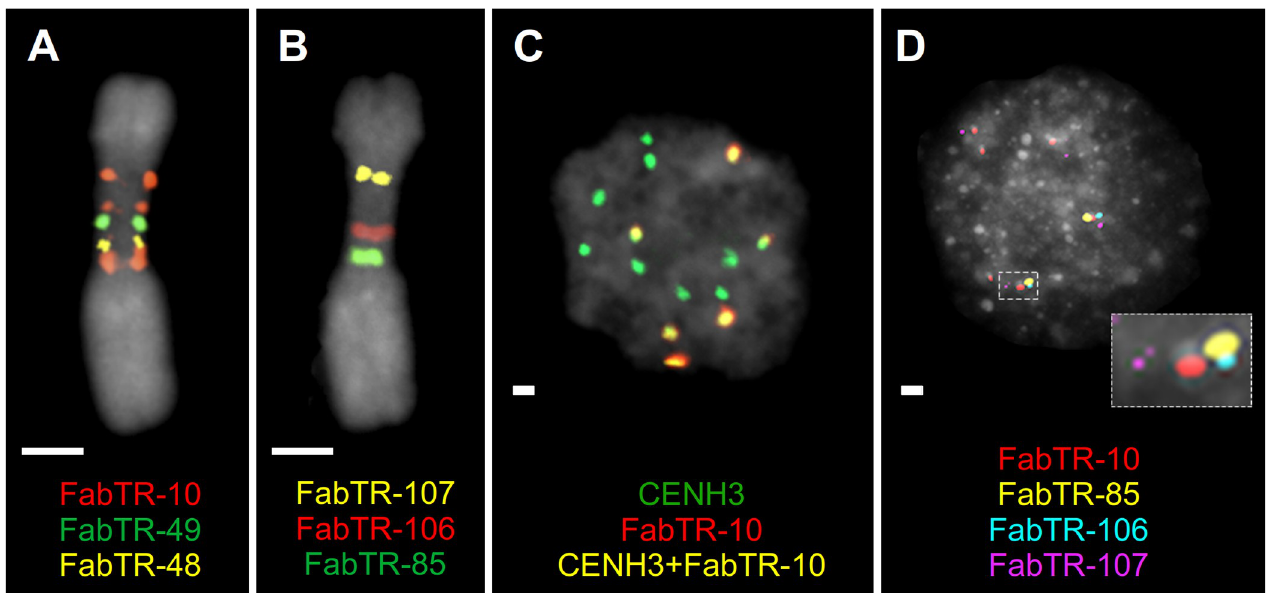
Fig 4. Association of repeats with CENH3 determines their position on chromosomes and condensation patterns in interphase nuclei. (A-B) Multicolor FISH detection of satellite repeats on metaphase chromosome 6. CENH3-associated satellite repeats are located along the periphery of the primary constriction (A) , whereas CENH3-free satellites are embedded within the constriction (B) . (C-D) Immuno-FISH detection of CENH3 protein and satellite repeats in interphase nuclei. (C) All CENH3 loci from each chromosome are condensed into a single spot, along with their associated satellites such as FabTR-10, resulting in 14 CENH3 signals per nucleus (2n = 14). Note that only a part of chromosomes contain FabTR-10. (D) CENH3-free satellites are located away from the condensed CENH3 domains of CEN6. The position of CENH3 chromatin is indicated with the FabTR-10 probe. Satellite repeats and CENH3 protein are labeled with different colors as indicated in the figures. Chromosomes and nuclei counterstained with DAPI are shown in gray. Bar = 2 μ m.